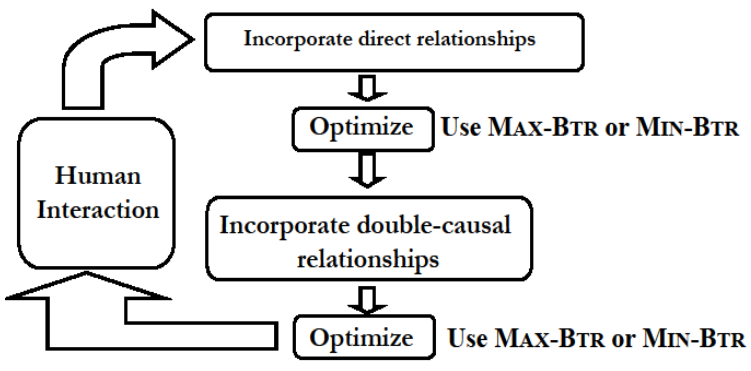
Figure 5. A schematic diagram of the network synthesis method in [5 (cid:177) 7]. Human interaction is necessary since some choices may have to be made in distilling the component relationships, e.g., when there are conflicting reports in the